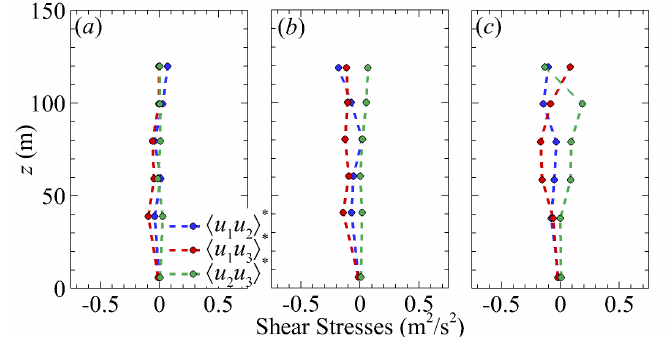
Figure 16. Vertical profiles of the shear components of the Reynolds stress tensor measured